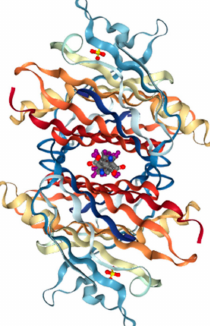
Figure 2. Transthyretin—T4 hormone binding structure. (PDB ID code; 2ROX